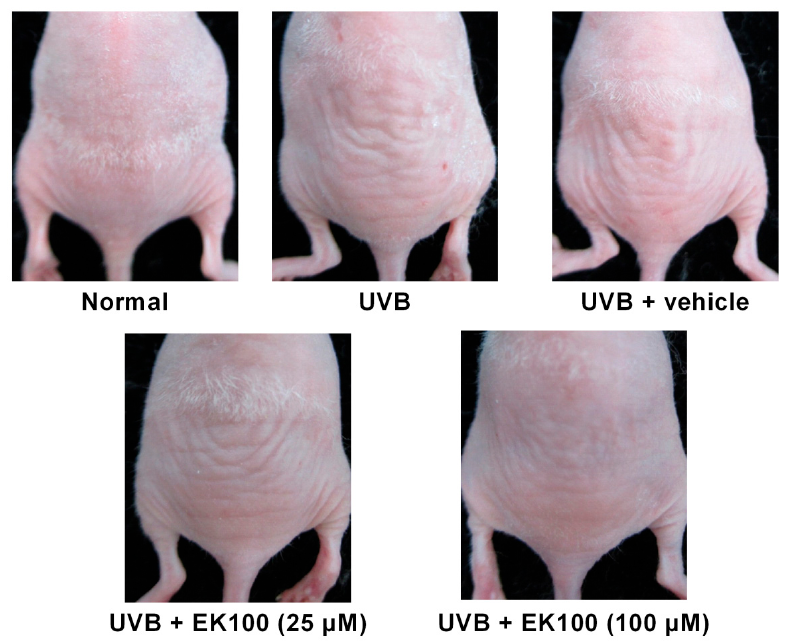
Figure 4. Photographs of wrinkles induced by UVB irradiation and the effect of topically applied EK100. UVB significantly increased the wrinkle formation on mouse skin, and EK100 reversed it. Table 1. Effects of EK100 on skin wrinkles induced by UVB irradiation in hairless mice.